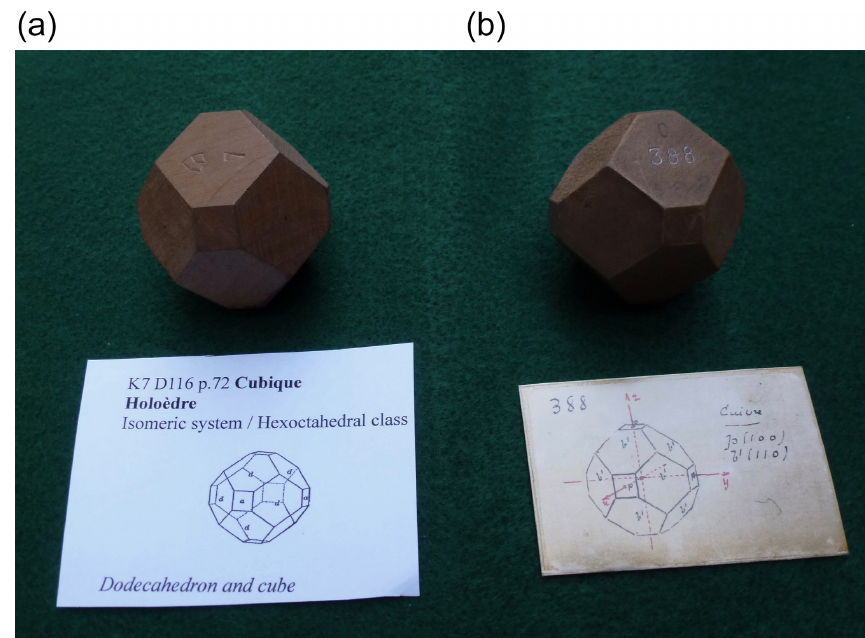
Figure 5. Example of duplication of the same crystallographic model: (a) with the Krantz logo and the label taken from Dana and Ford (1932) and (b) one of the first series with the label taken from the cardboard